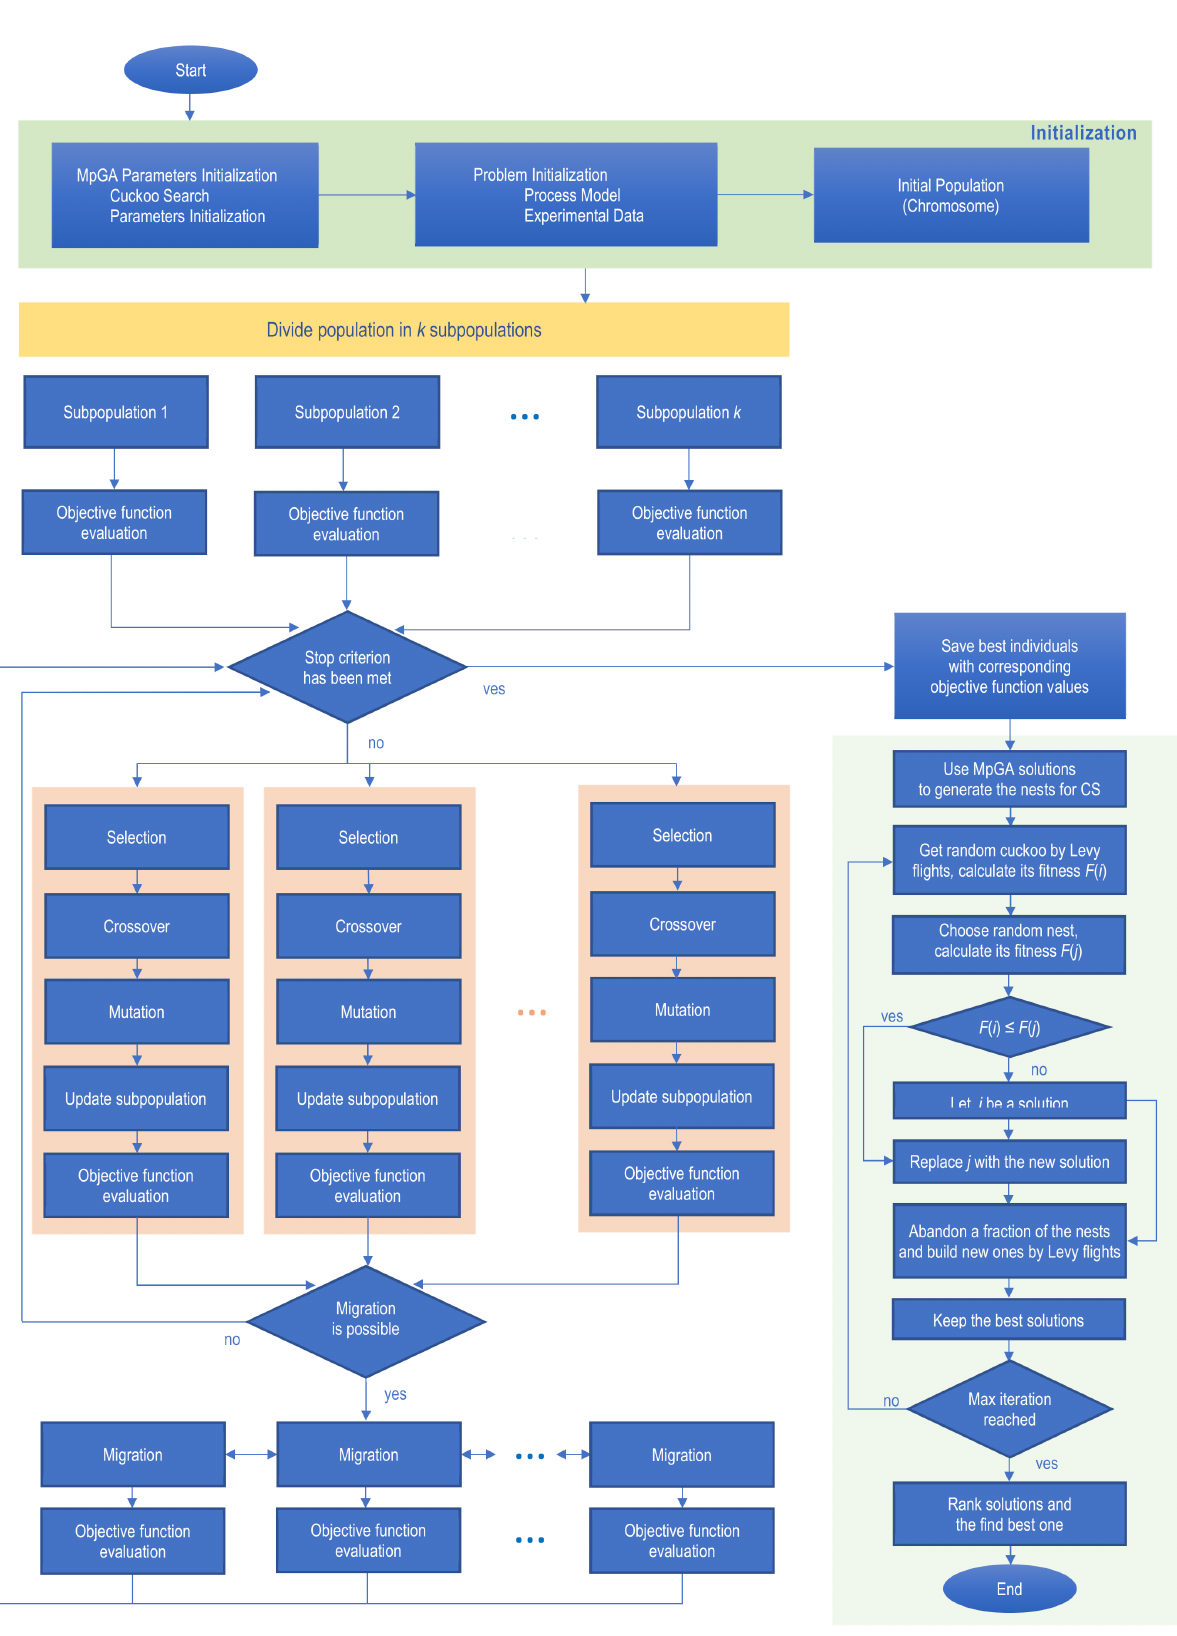
Figure 2. Flow chart of MpGA-CS hybrid